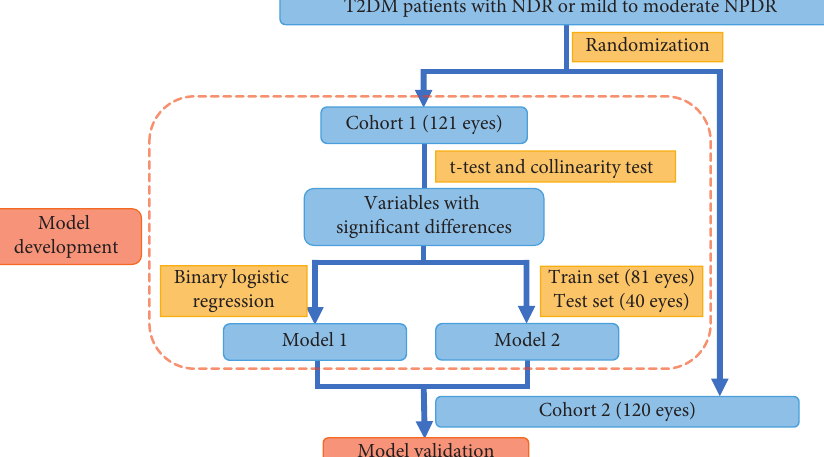
Figure 2: Flowchart of the development and validation in two models. T2DM, type 2 diabetes mellitus; NDR, nondiabetic